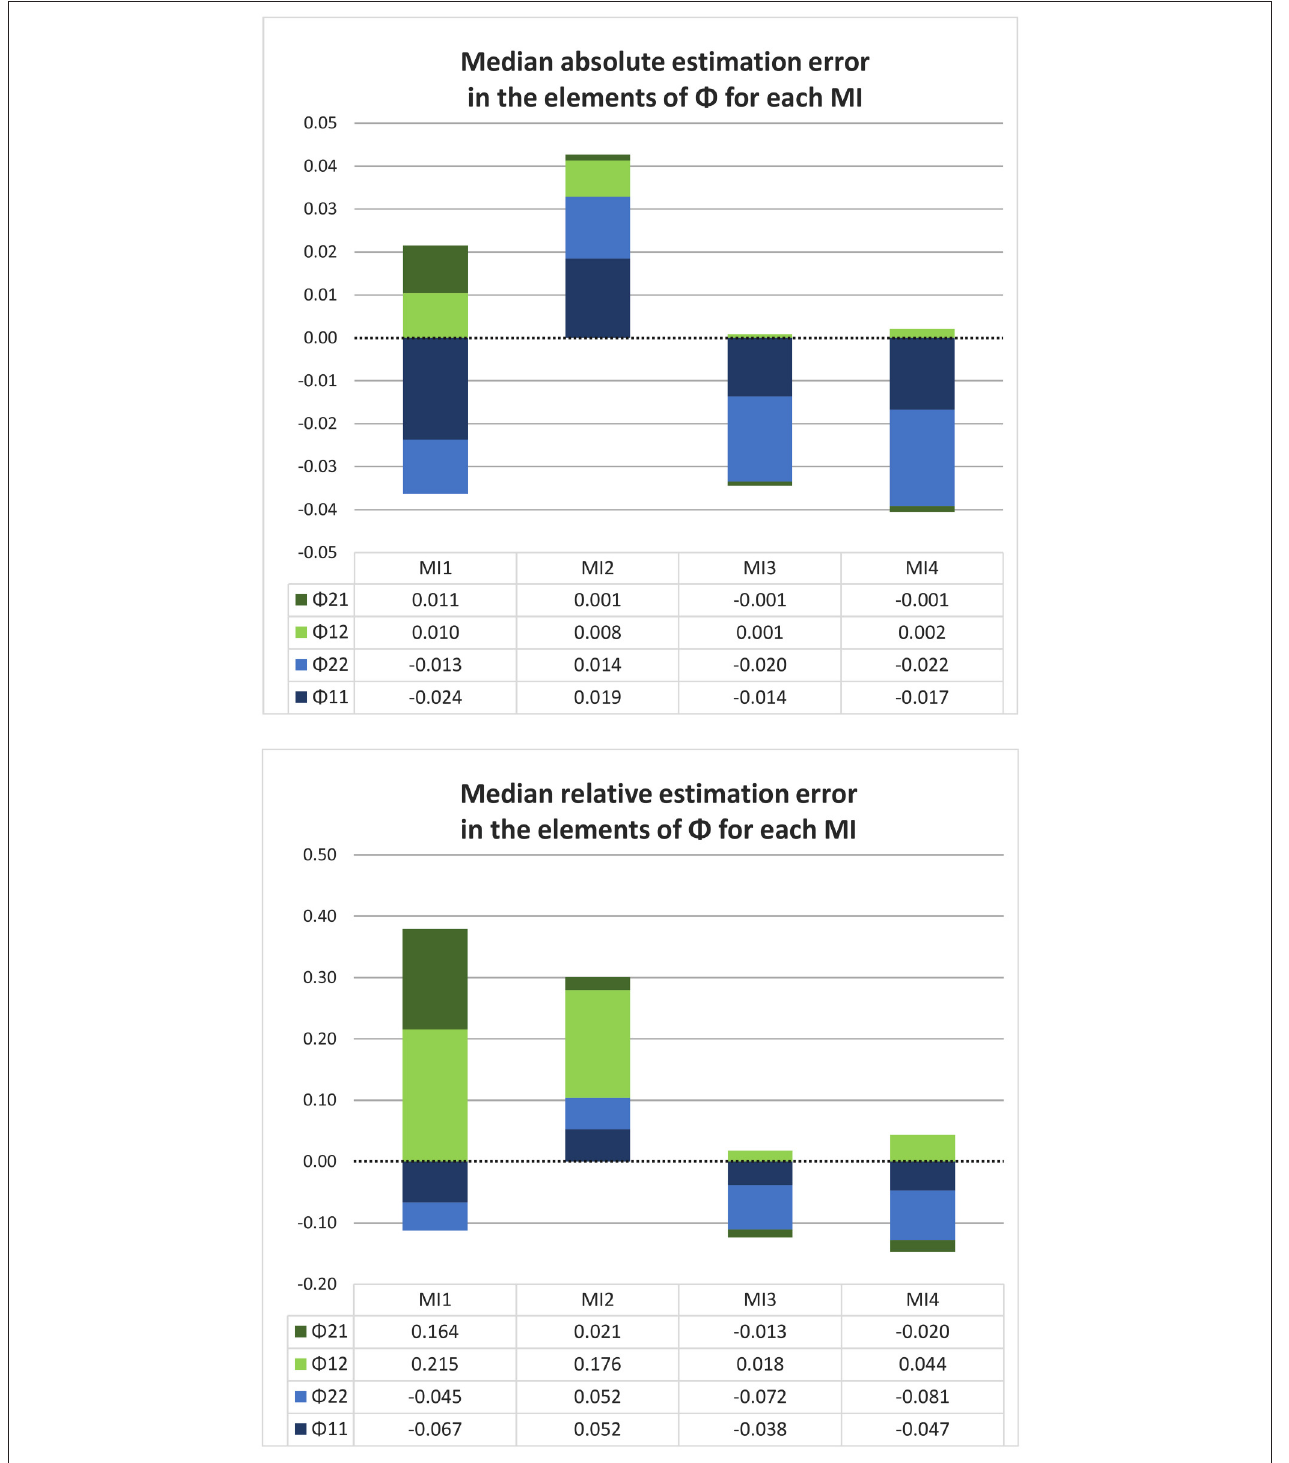
FIGURE 7 | Median absolute and relative estimation error in 8 for each model implementation, over one thousand shorter (10-day) bivariate time series, with no minimum interval length. In this graph, each stacked bar represents a model implementation and each color represents a different element of 8 . In terms of the total amount of absolute estimation error, MI 2 and MI 4 are hard to distinguish and only MI 1 is clearly more biased than the rest; but when we consider the relative estimation error, it is clear (from the length of the stacked bars) that MI 3 and MI 4 outperform the other two MIs. MI 2 stands out because it is the only MI that overestimates the